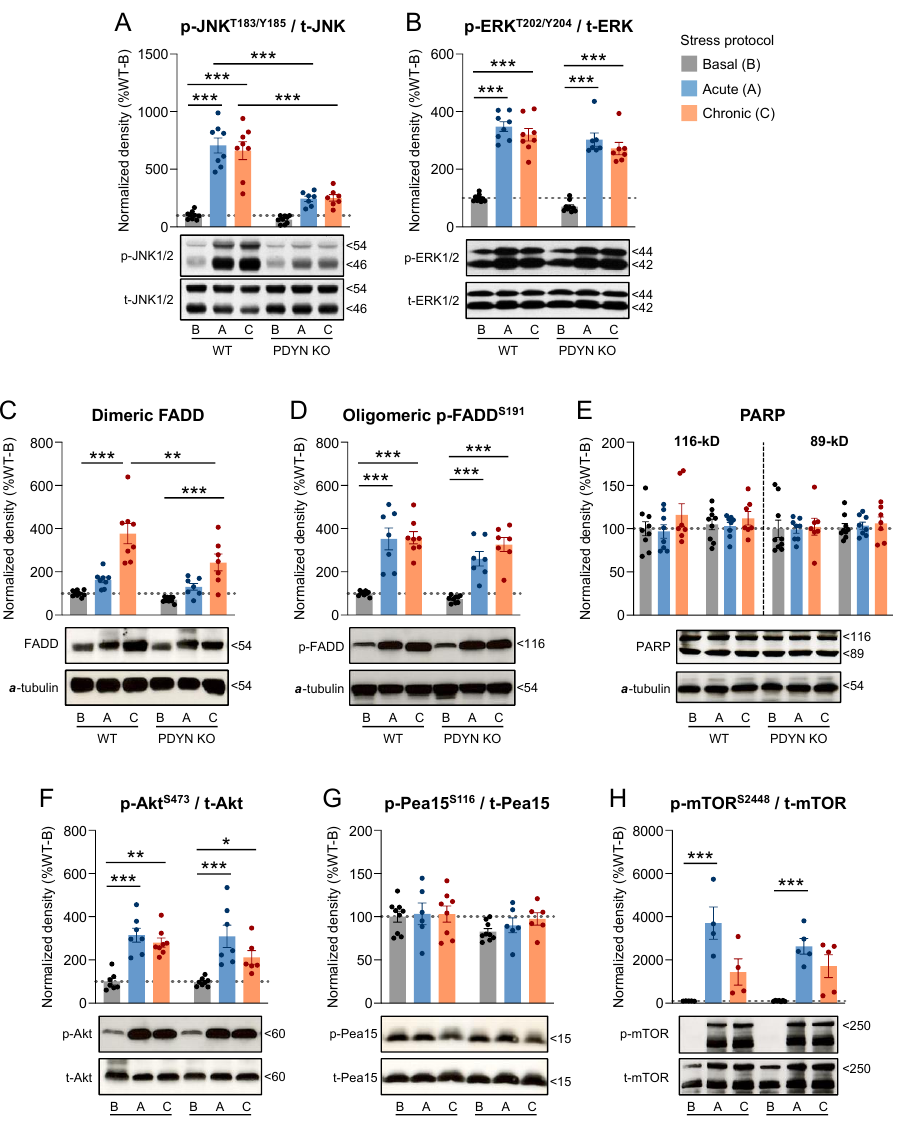
Figure 4. Cortical immunodensities of ( A ) activated p-Thr183/Tyr185 JNK1/2, ( B ) activated p-Thr202/Tyr204 ERK1/2, ( C ) dimeric FADD, ( D ) oligomeric p-Ser191 FADD, ( E ) full-length and cleaved PARP, ( F ) activated p-Ser473 Akt, ( G ) p-Ser116 Pea15, and ( H ) activated p-Ser2448 mTOR in WT and PDYN-KO mice exposed to acute restraint ( A , blue bars) or chronic mild ( C , orange bars) stress procedures, as compared to basal ( B , grey bars) stress levels in undisturbed animals. Normal- ized protein amounts were estimated as the ratio between the corresponding immunoreactive band to total enzyme or α -tubulin. Columns are means ± SEM of n = 7–9 mice per experimental group and expressed in percent change from wildtype-basal (WT-B) mice. All datasets were analyzed by TW- ANOVA (see Table 1). * p < 0.05, ** p < 0.01, and *** p < 0.001, TW-ANOVA followed by Tukey’s post hoc test. ( A – H ) Representative immunoblots of phosphorylated and/or non-phosphorylated species of the indicated proteins are shown at the bottom. The indicated molecular weights (in kDaltons, kDa) of the immunoreactive bands were estimated from in-gel-loaded, prestained protein